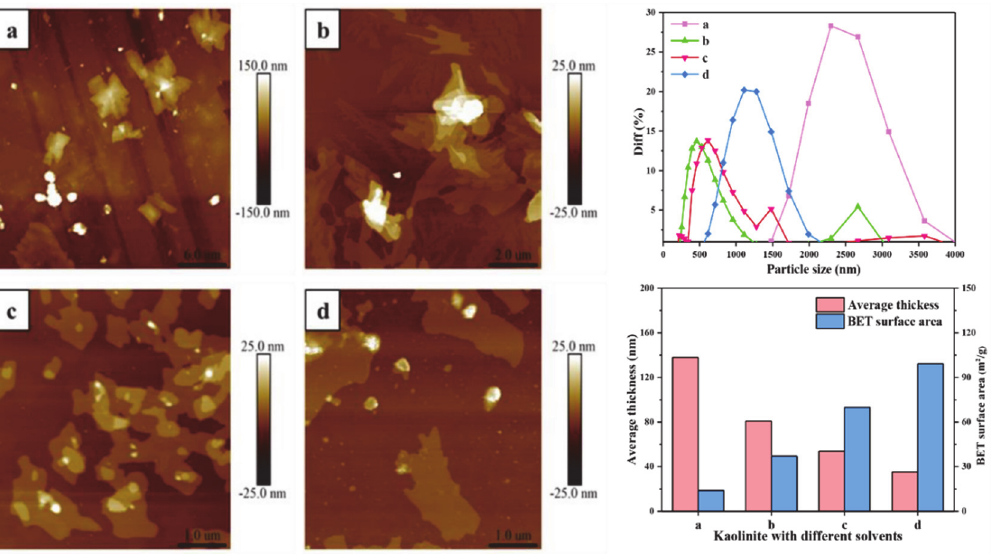
Figure 7. Nano particle size, thickness and BET surface area of ( a ) original kaolinite; ( b ) the KAc– kaolinite complex; ( c ) the FA − kaolinite complex and ( d ) the DMSO − kaolinite complex.